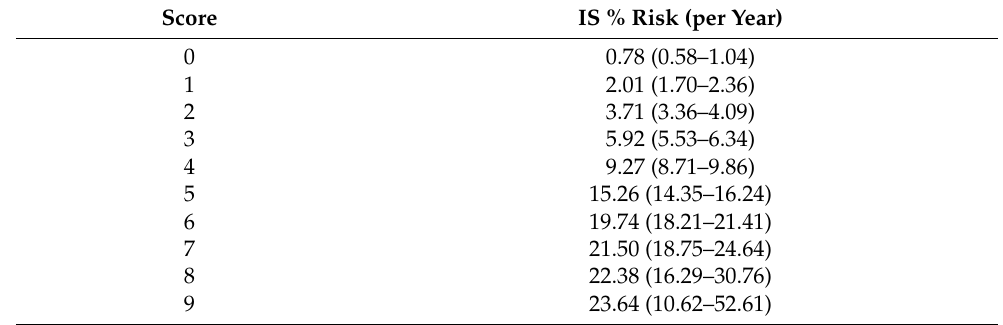
Table 1. CHA 2 DS 2 -VASc score relative